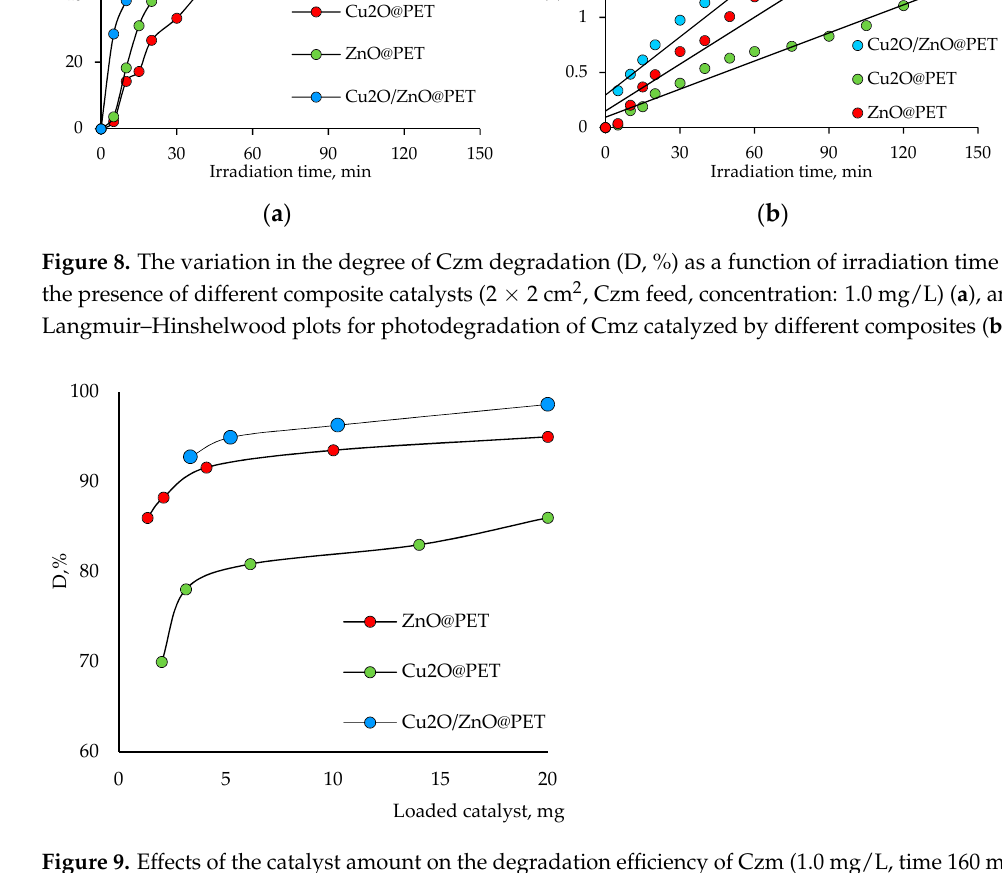
Figure 8. The variation in the degree of Czm degradation (D, %) as a function of irradiation time in the presence of different composite catalysts (2 × 2 cm 2 , Czm feed, concentration: 1.0 mg/L) ( a ), and